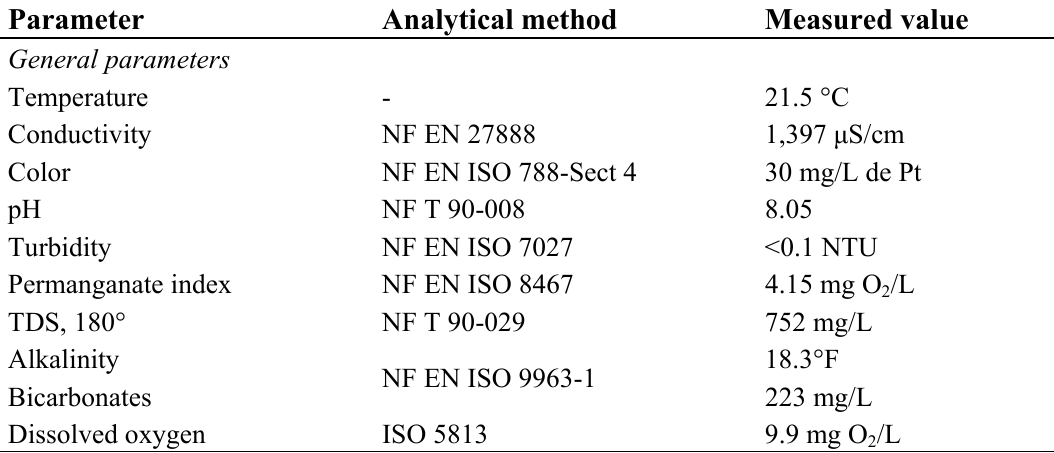
Table 2. Analysis of selected water quality parameters in the recycled